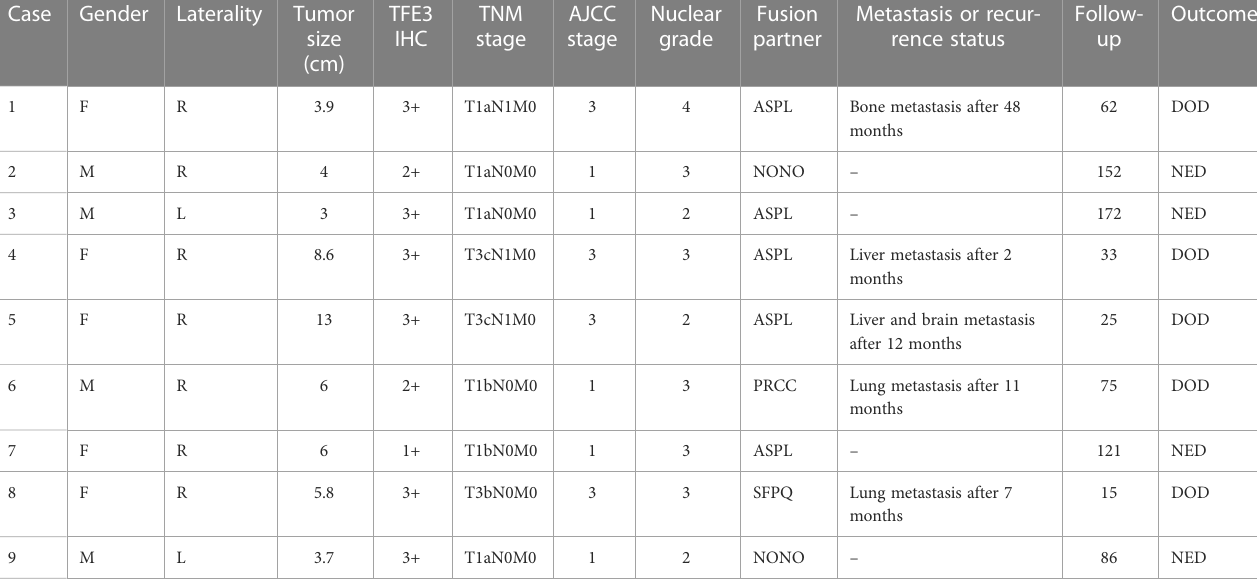
TABLE 1 The clinicopathologic features of the 40 Xp11.2 tRCC patients.